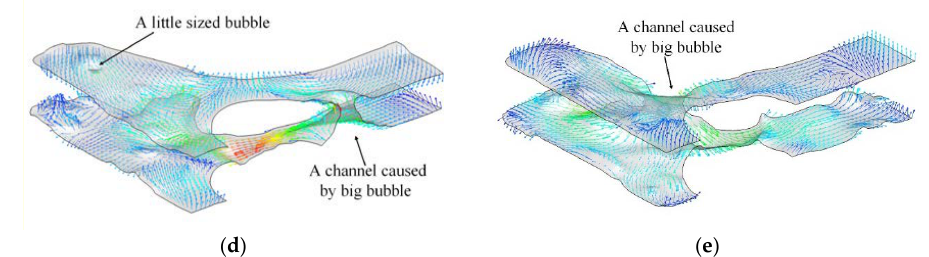
Figure 8. Typical velocity vectors of slag/steel interface and slag/air interface. ( a ) sketch of slag/steel interface and slag/air interface; ( b ) shape of slag/steel interface and slag/air interface with a big bubble began getting into the slag layer; ( c ) shape of slag/steel interface and slag/air interface with a big bubble at a later time than ( b ); ( d ) shape of slag/steel interface and slag/air interface with a little sized bubble and a channel; ( e ) shape of slag/steel interface and slag/air interface with a channel.